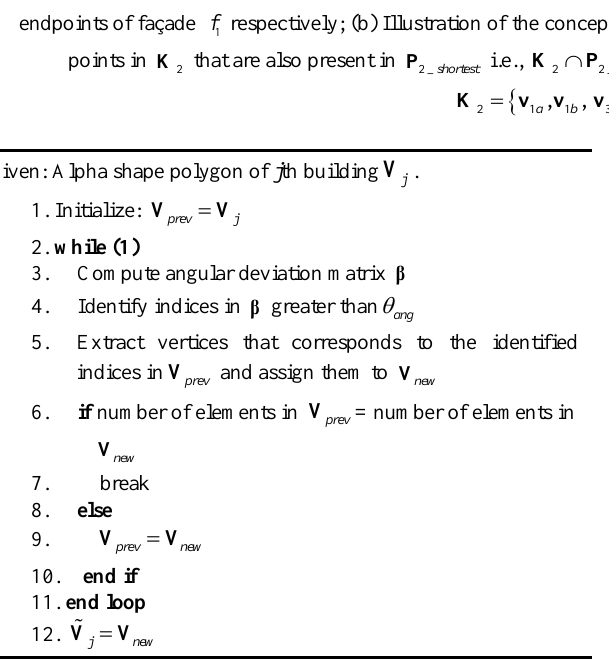
P and P  . Refined polygon of one particular j th building _ t shortest , , and f f f f that are to be incorporated. (a) illustrates the concept of shortest and 1 2 3 4 v and v denotes the closest points on the polygon/graph f . 1 a 1 b 1